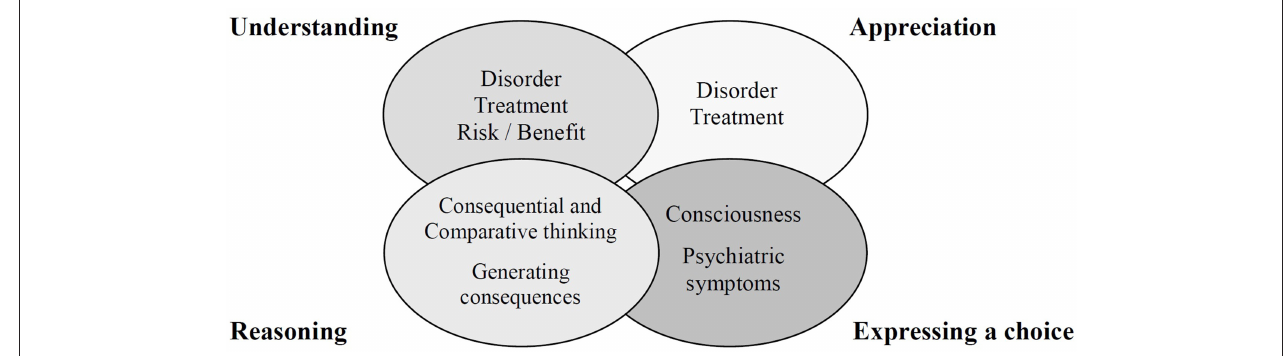
FIGURE 1 | Key elements of the MacArthur Competence Assessment